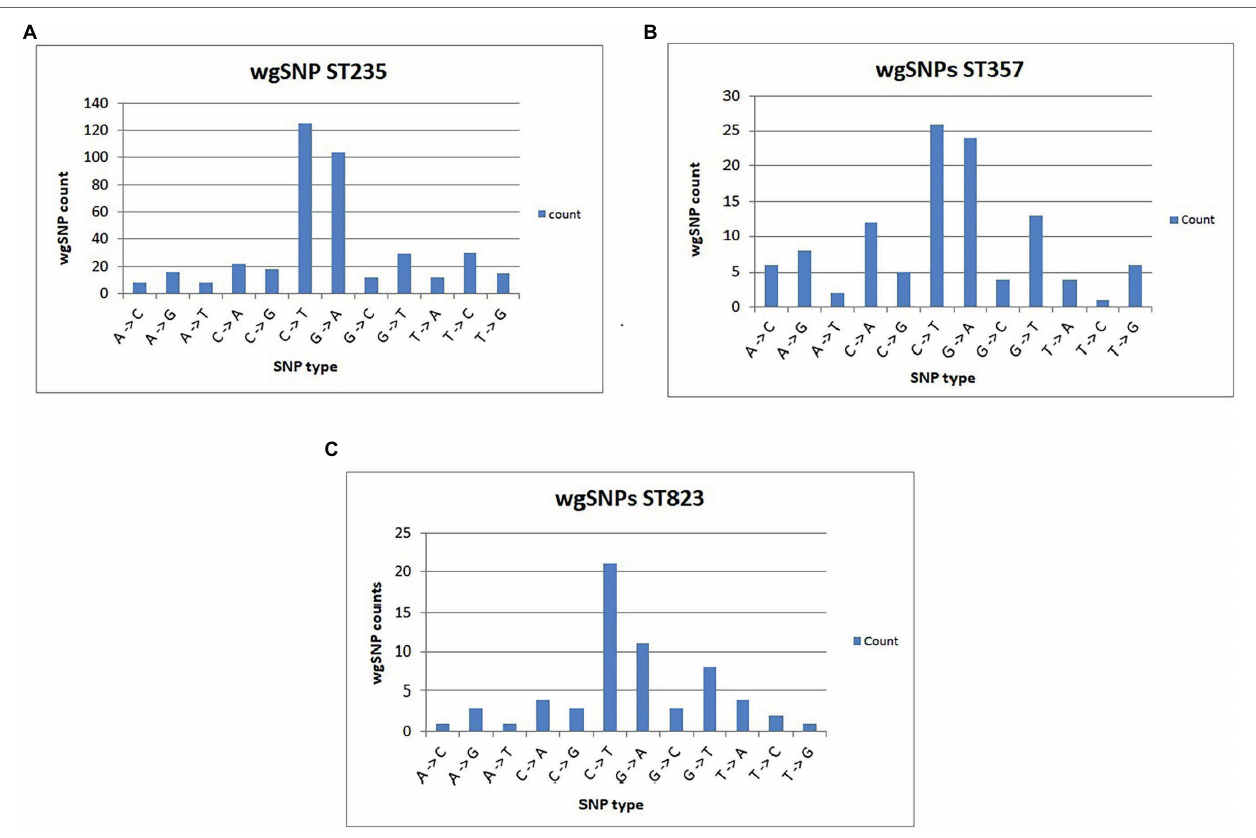
FIGURE 4 | Number of different SNP types with reference to PAO1 strain of P. aeruginosa is illustrated for CNPA clone ST235 (A) , clone ST357 (B) and clone ST823 (C)